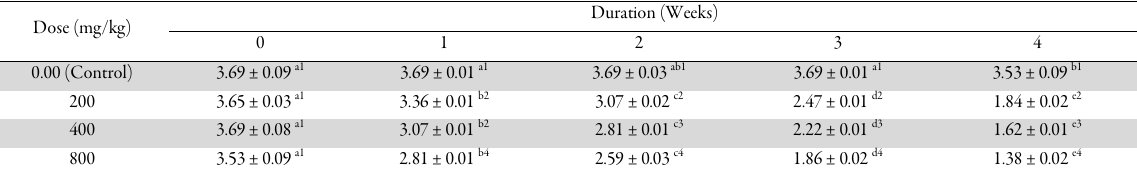
Table 7. Effect of Lipton tea aqueous extract on coronary risk index (mmol/l) of normal albino rats Dose